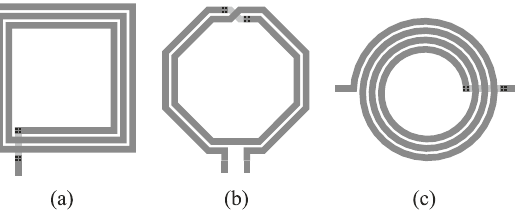
Figure 1. Typical on-chip inductors: ( a ) rectangular coil in single-ended configuration, ( b ) octagonal coil of differential type, and ( c ) circular coil in unbalanced configuration. Windings, undercrossing, and vias are represented in the picture by dark gray, light gray, and black colors, respectively.